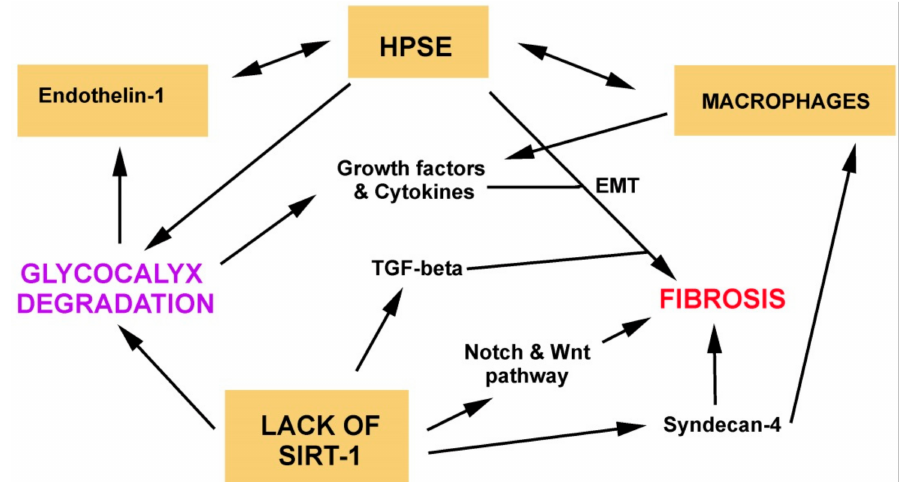
Figure 2. A series of noxa (ischemia/reperfusion (I/R), ROS, diabetes hyperinsulinemia, sepsis) increases heparanase production, which participates in glycocalyx degradation and the release of growth factors. Heparanase and these factors then sustain fibrosis via the activation of the EMT process. There is close interaction between macrophages and heparanase in the regulation of the fibrotic process. The production of heparanase is moreover sustained by a vicious loop with endothelin-1 released during glycocalyx degradation. In addition, the reduction of sirtuin-1 increases TGF-beta signaling fueling fibrosis via EMT. The lack of sirtuin-1 also induces fibrosis through the activation of the Notch and Wnt signaling pathways and the release of syndecan-4, which acts as a